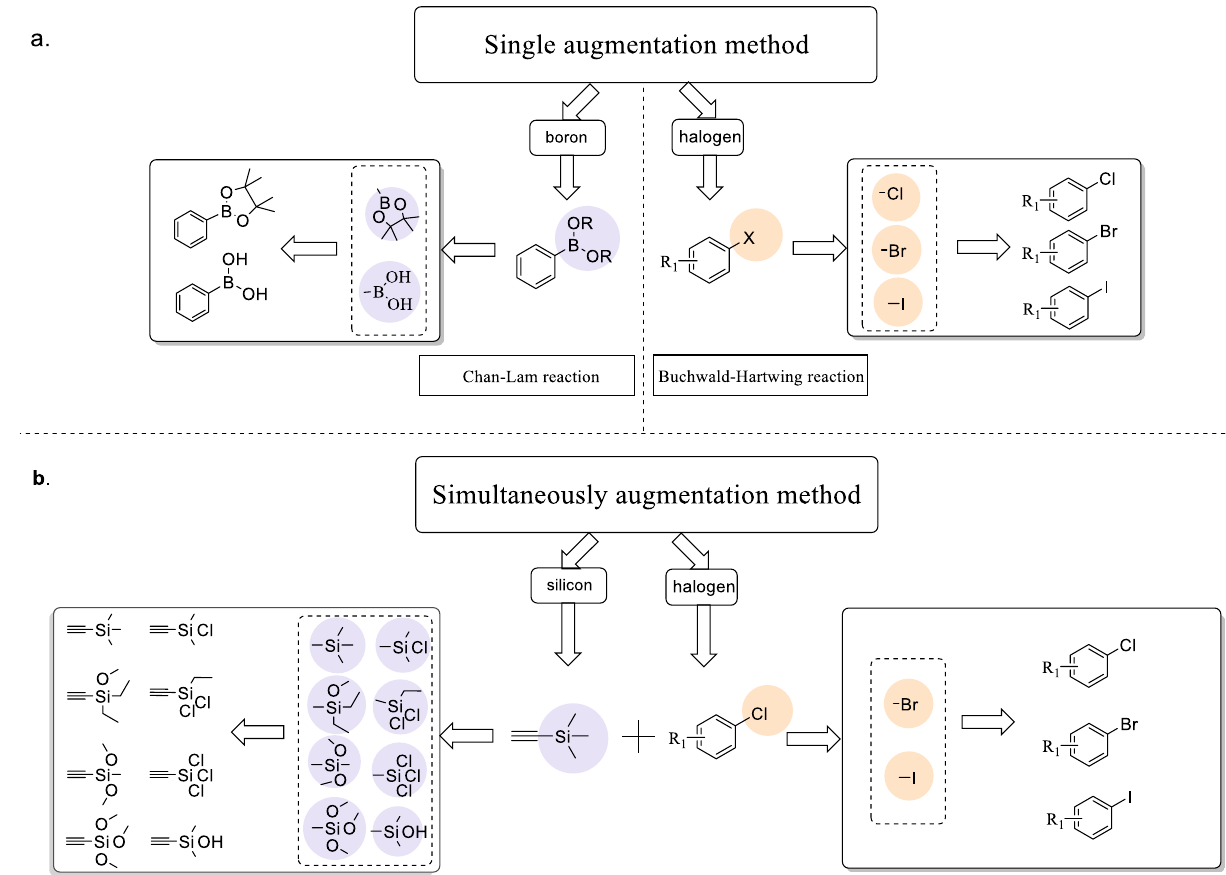
Figure 2. The schematic diagram of virtual data augmentation. ( a ) The single augmentation method of Buchwald-Hartwig and Chan-Lam coupling reactions. ( b ) The representative example of simultaneously virtual data augmentation method of Hiyama coupling reaction.